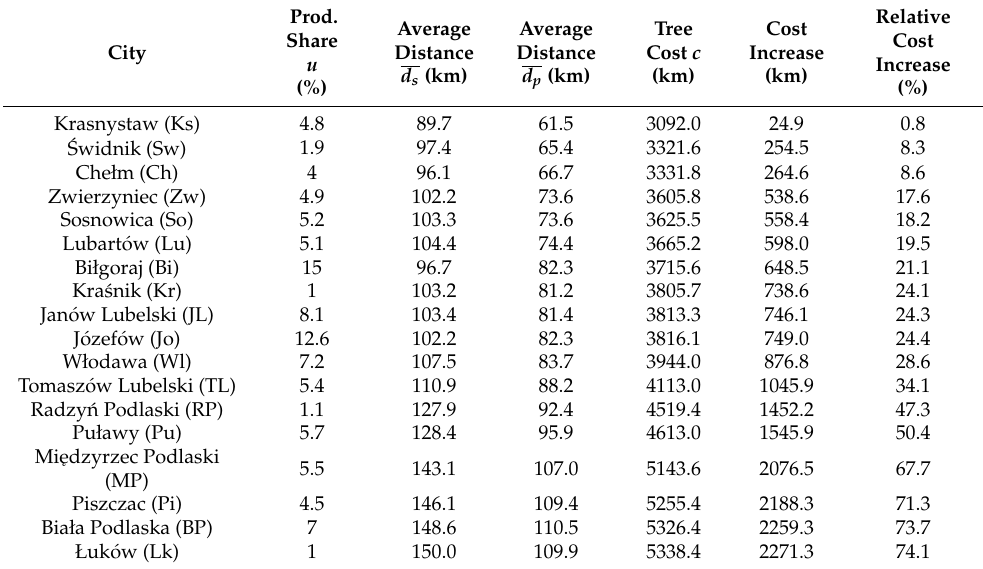
Prod. Average Average Share Distance Distance u d s (km) d p (km) (%)